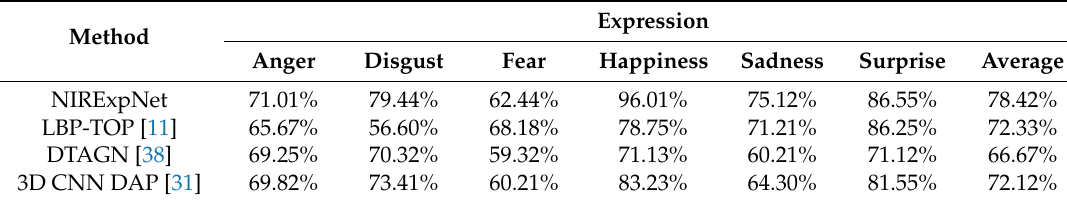
Table 5. Comparisons of different methods on the Oulu-CASIA NIR